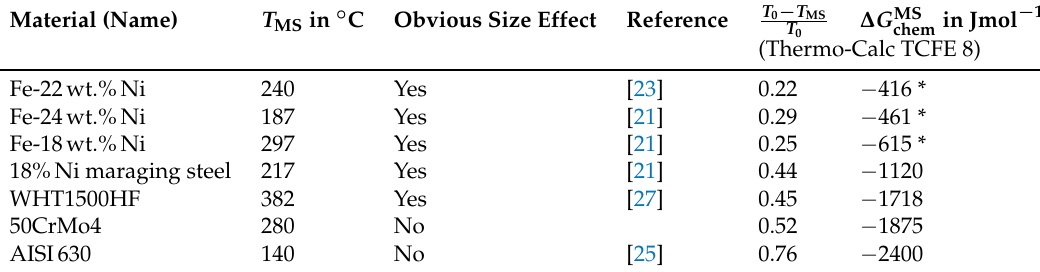
Table 3. Comparison of relative differences between the equilibrium temperature and martensite